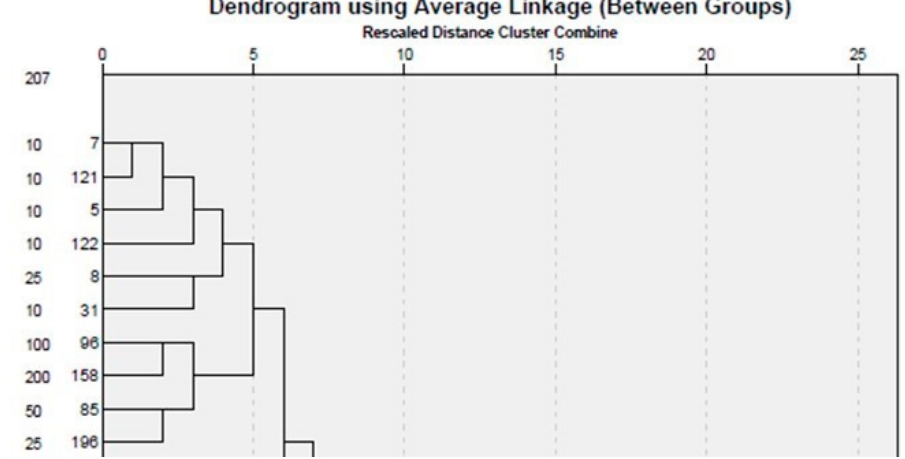
Figure 6. The dendrogram fragment for cluster A. Table 5. The individual responses of respondents from cluster